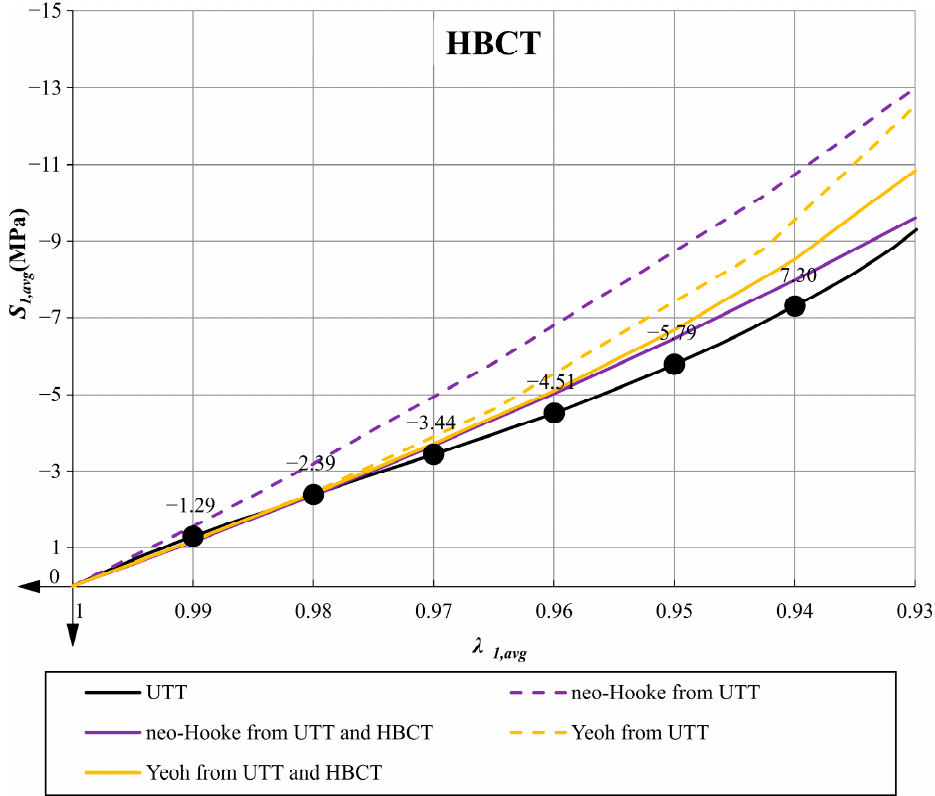
Figure 12. Comparative plot of average pressure stress S 1,avg as a function of the average elongation λ 1,avg in case of HBCT.